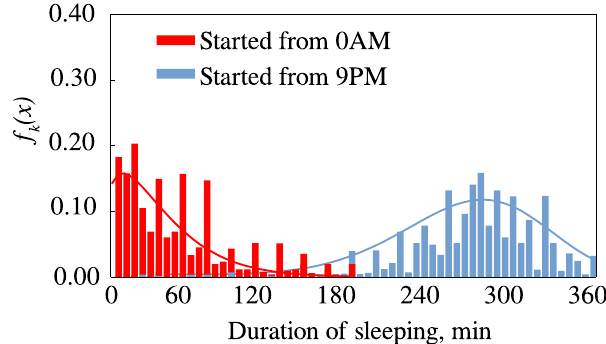
Figure 4. Examples of PDFs of sleeping, and their fitted Gaussian distributions.